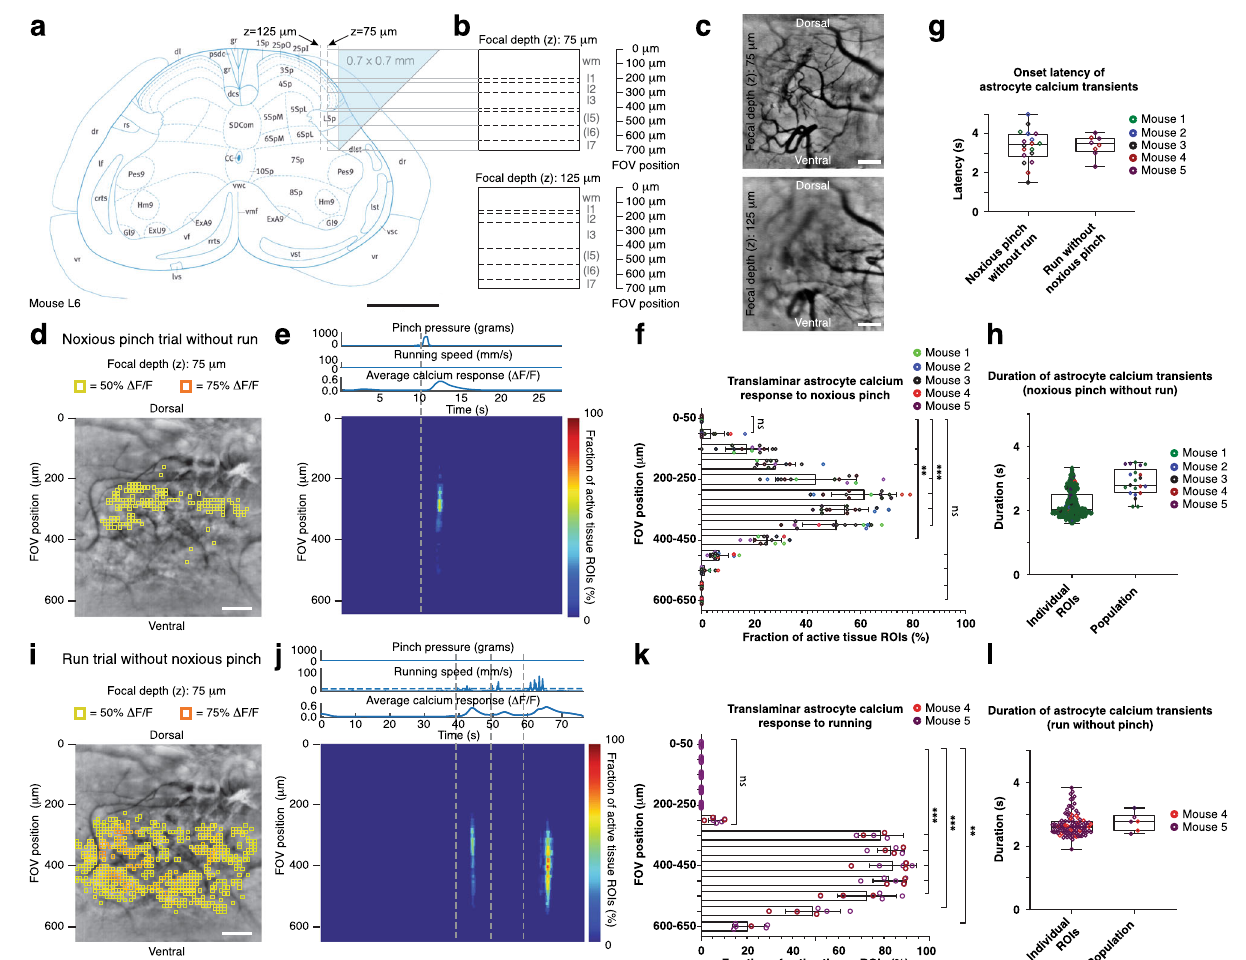
Fig. 4 | High-speed translaminar imaging reveals region-speci fi c sensory and motor-evoked activity in behaving GFAP-GCaMP6f mice. a Schematic showing the translaminarimaging approach. An0.7mm×0.7mm×0.7mm glass re fl ective microprism wasinserted atthe lateralinterface betweenthe spinal gray and white matter at the L4-L5 spinal level without tissue removal ( Methods ). The micro- prism ’ s re fl ective hypotenuse tilts the microscope ’ s imaging plane by 90 degrees allowing high-speed measurements across laminae. Imaging was performed at 75 μ m or 125 μ m focal depth from the vertical microprism face. Scale bar, 0.5mm. b Predicted extent and borders of spinal laminae across the 700 μ m fi eld of view (FOV) for 75 μ m (top) and 125 μ m focal depths (bottom). c Example fl uorescence images showing the translaminar blood vessel pattern in a GFAP-GCaMP6f mouse at75 μ m and 125 μ m focaldepths four weeks after microprism implantation. Scale bars, 100 μ m. d Average intensity projection image from a different GFAP- GCaMP6fmouseat75 μ mfocaldepthoverlaidwith10 μ m×10 μ mROIs.OnlyROIs with at least 50% (yellow) or 75% Δ F/F (orange) in response to a noxious tail pinch (p>500g; duration: 1.5s±0.5s) are shown. In this example, the tail pinch did not evoke a locomotor response. Scale bar, 100 μ m. e Noxious tail pinch evoked activity across tissue depth and time for the example recording shown in d. Each row depicts the percent of active ROIs ( ≥ 50% Δ F/F) for a given tissue depth. The corresponding pressure stimulus, locomotor activity, and average calcium tran- sient across the FOV are shown above the activity heat map. Running speed was recorded by placing the animal on a spherical treadmill (Supplementary Movie 3). The vertical dashed line indicates pinch onset. f Population data showing the